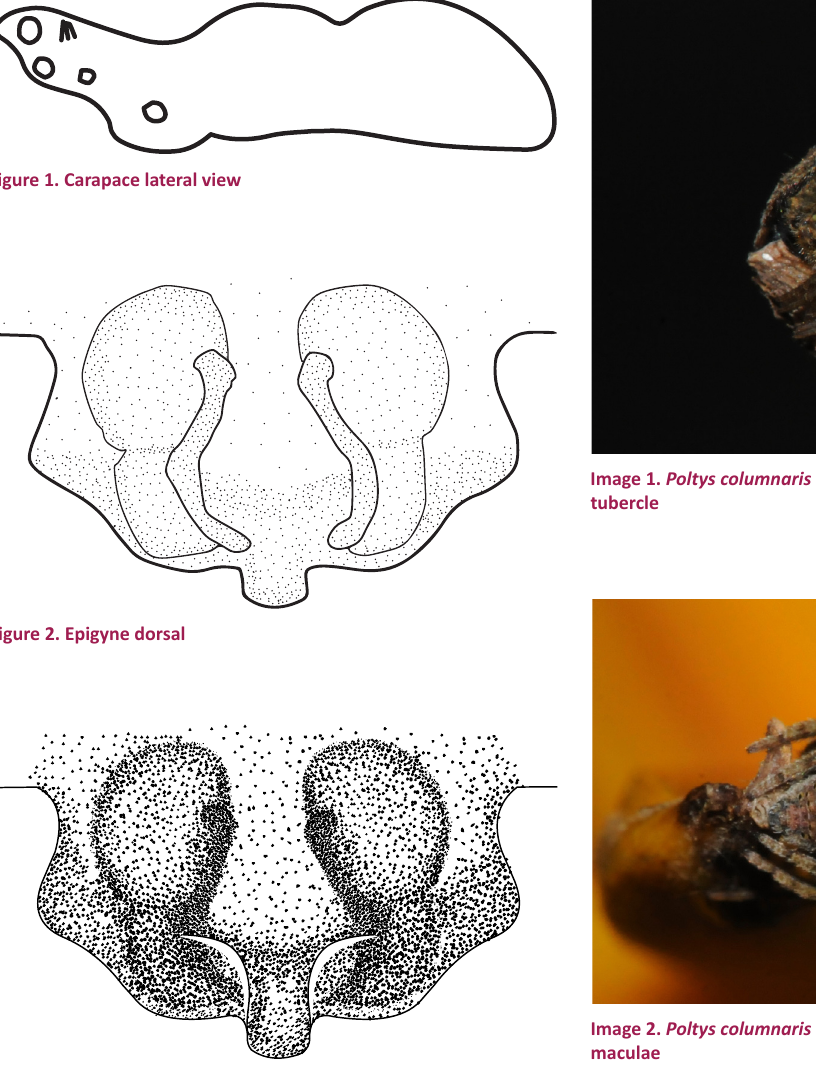
Figure 3. Epigyne ventral